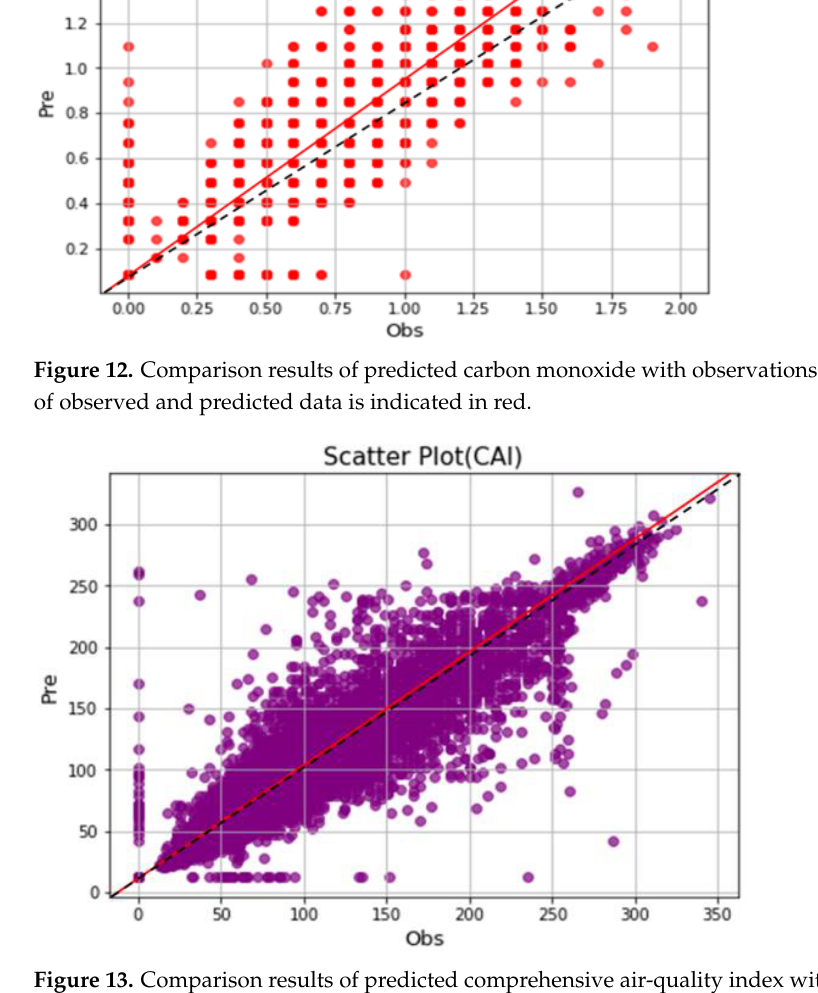
Figure 13. Comparison results of predicted comprehensive air-quality index with observations. The regression line of observed and predicted data is indicated in red. 3.3. Analysis of CAI Using Ordinary Kriging Method In this study, the ordinary kriging method was used to determine the spatial distri- bution of the predicted CAI over South Korea. A variogram is expected to square the dif- ference between two points separated by a lag. The variogram measures the similarity of data at a certain distance and decreases as the distance between two points decreases. As the distance increases, the variogram increases or the correlation is lost and, thus, has a meaningless value. Therefore, the isolation distance at which the correlation and tendency are lost in the variogram is defined as a range. The variogram value at that distance is defined as a sill. There are empirical variograms and theoretical variograms, and a theo- retical variogram that minimizes prediction error was selected for considering spatial in- terrelationships. In the case of ordinary kriging, the sill converges to the variance of the